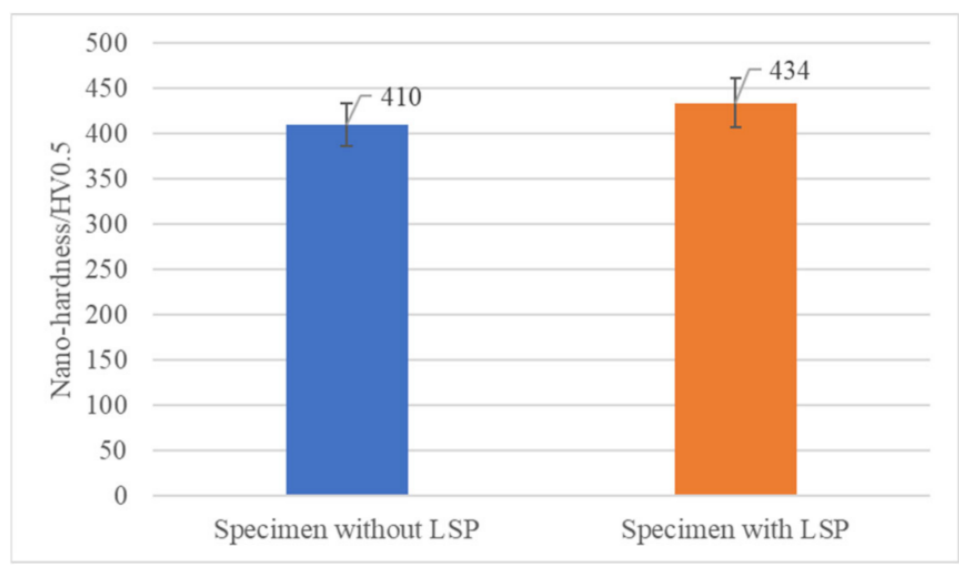
Figure 9. The microhardness of specimens without LSP and specimens with LSP.